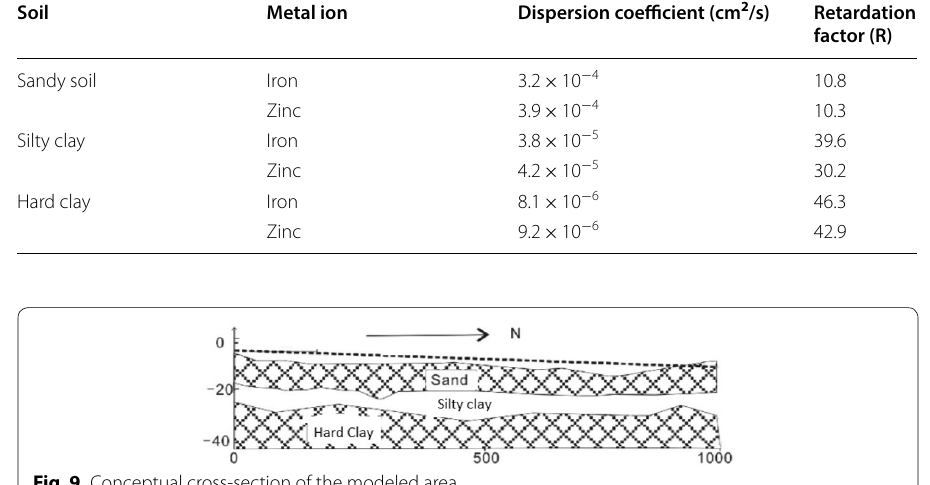
Table 5 Contaminant transport parameters of column test samples Soil